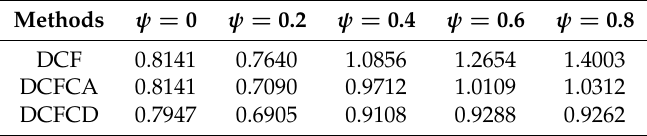
Table 2. Velocity ARMSE of different colored noises.